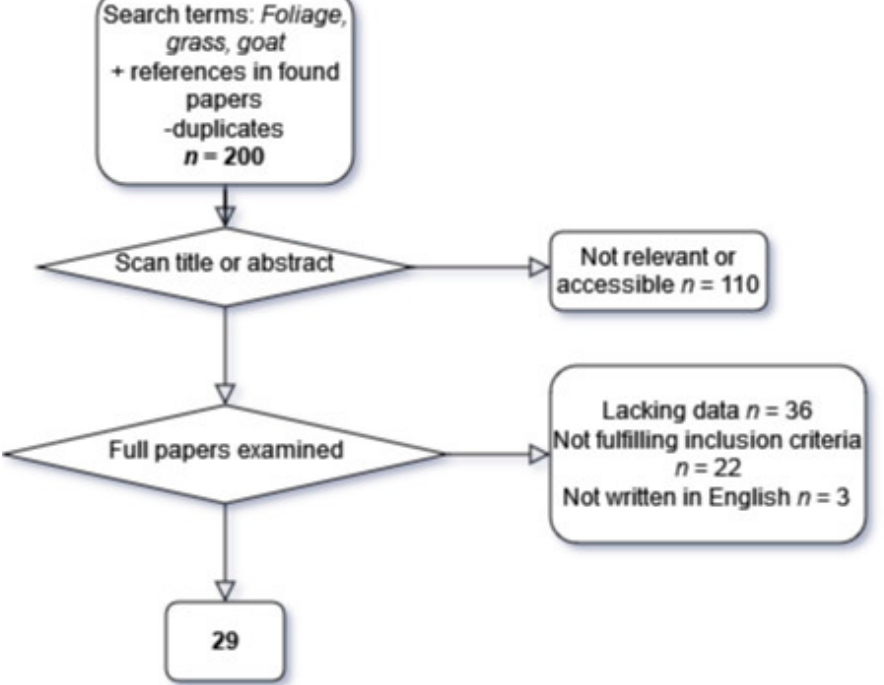
Figure 1. Flowchart for selection of publications for the meta-analysis.